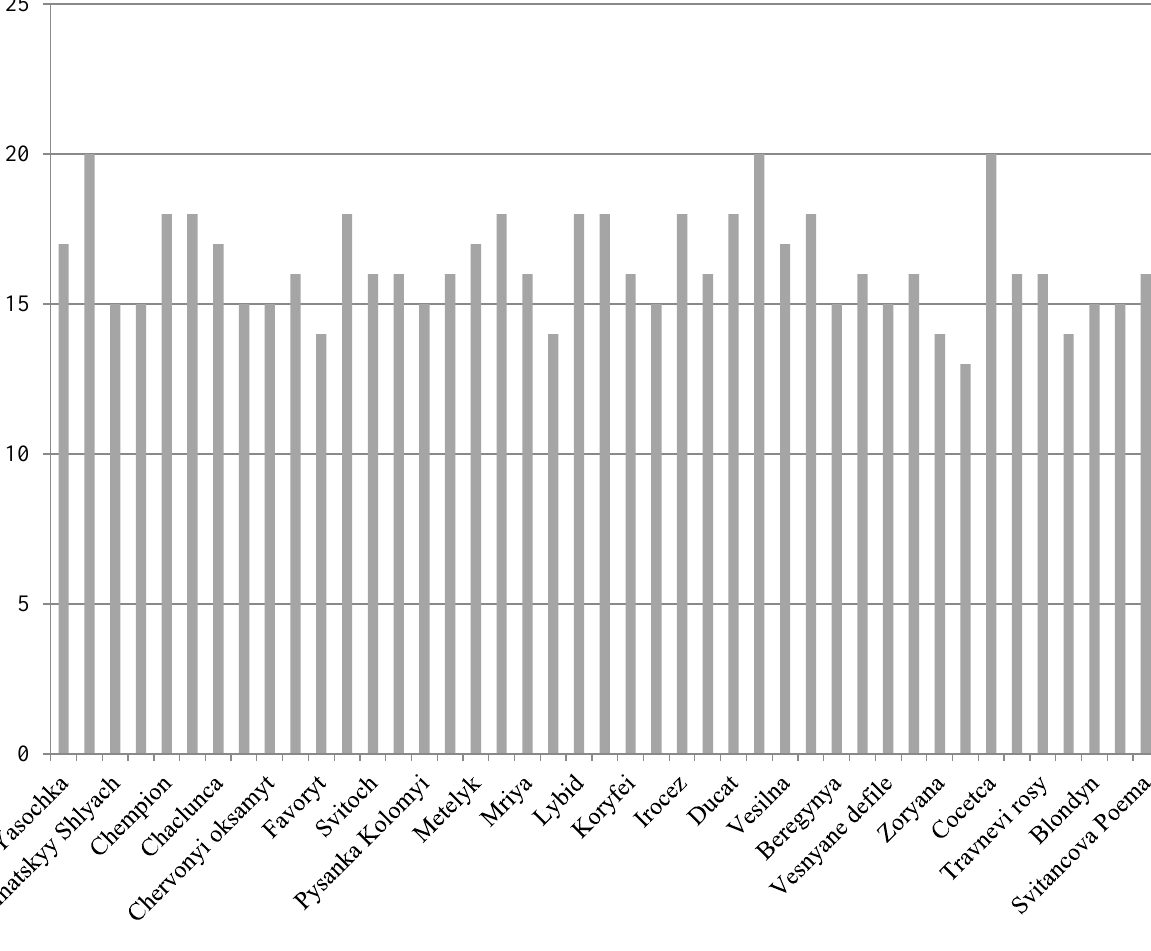
Table 2. Decorative value of varieties Paeonia